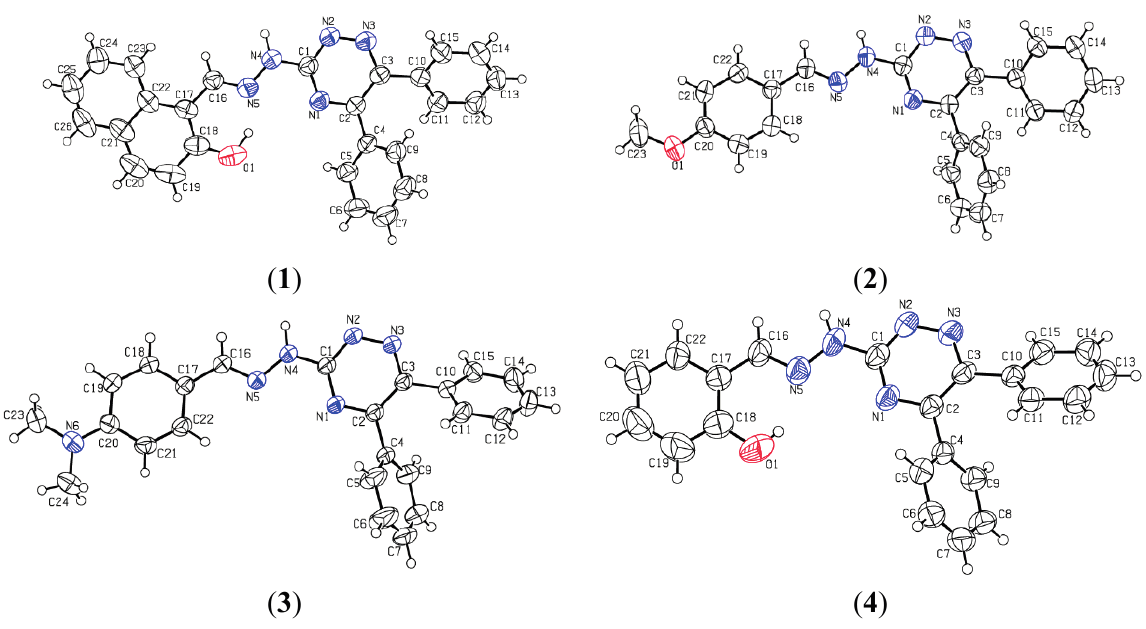
Figure 2. ORTEP diagrams of compounds 1 – 4 . Thermal ellipsoids were drawn at 50% probability